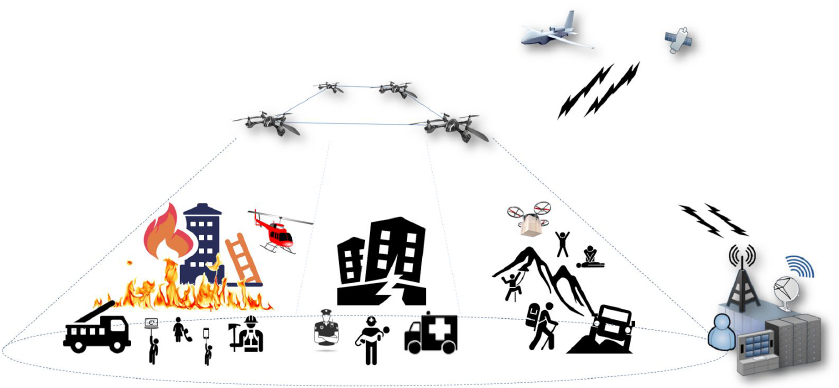
Figure 3: motivating scenarios Figure 1. Scenarios for UAS deployment: e.g., fire extinction, natural disasters or search and